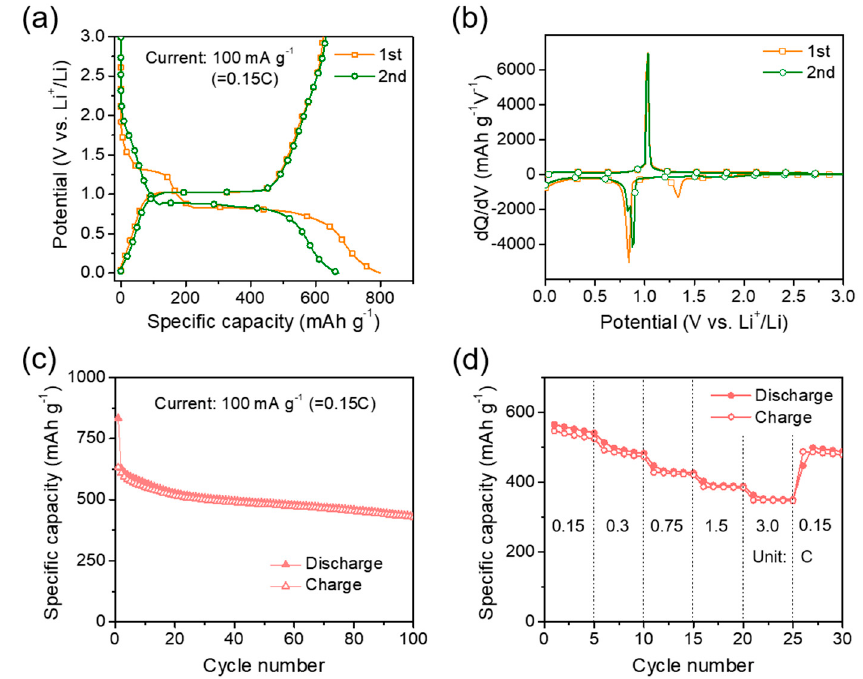
Figure 6. ( a ) Voltage profiles, ( b ) differential capacity plots, ( c ) cycle performance, and ( d ) rate performance of the spherical Sb core/Nb 2 O 5 -C double-shell structured composite electrode.